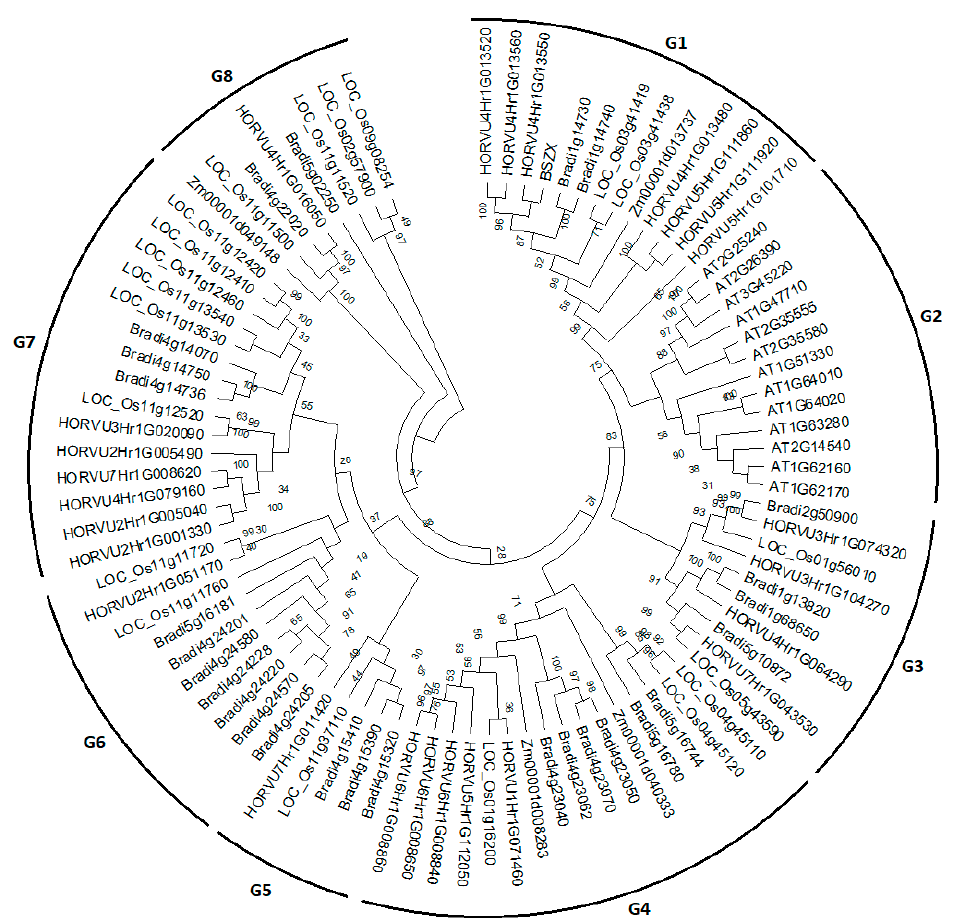
Figure 5. Phylogenetic analysis of serpin genes in Brachypodium (Bd21), barley, rice, maize and Arabidopsis by MEGA 6.0 software.